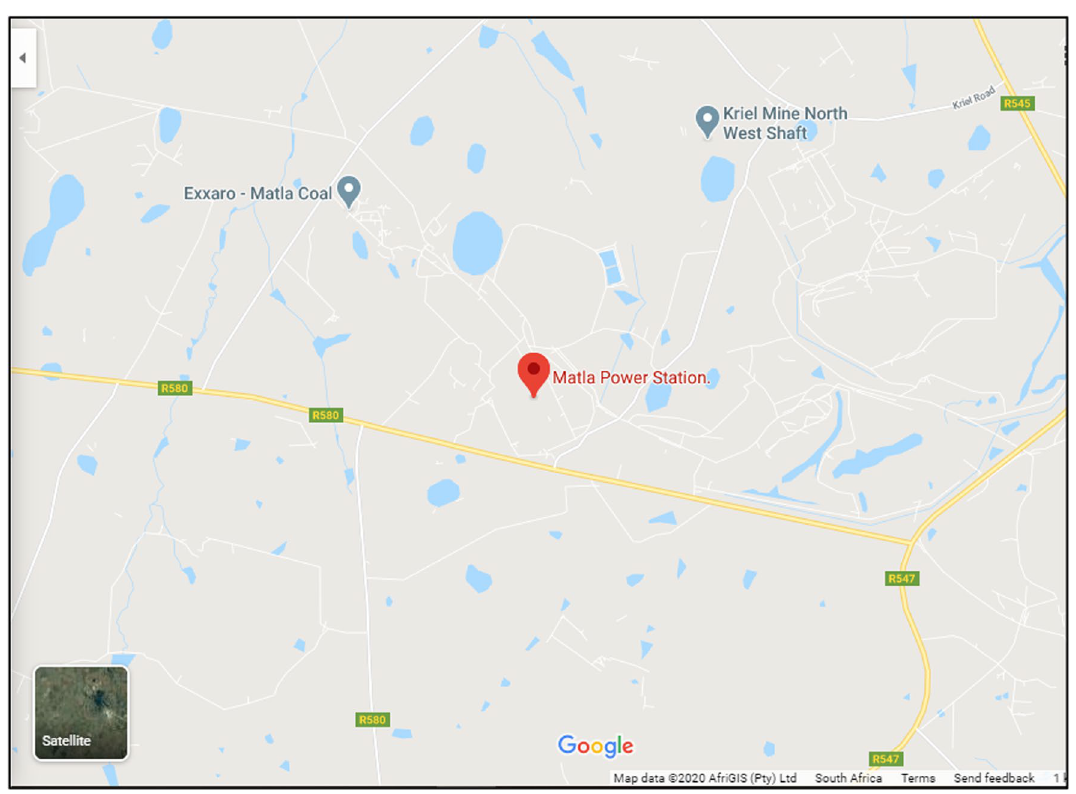
Fig. 1 Matla Power Station (S26.28036